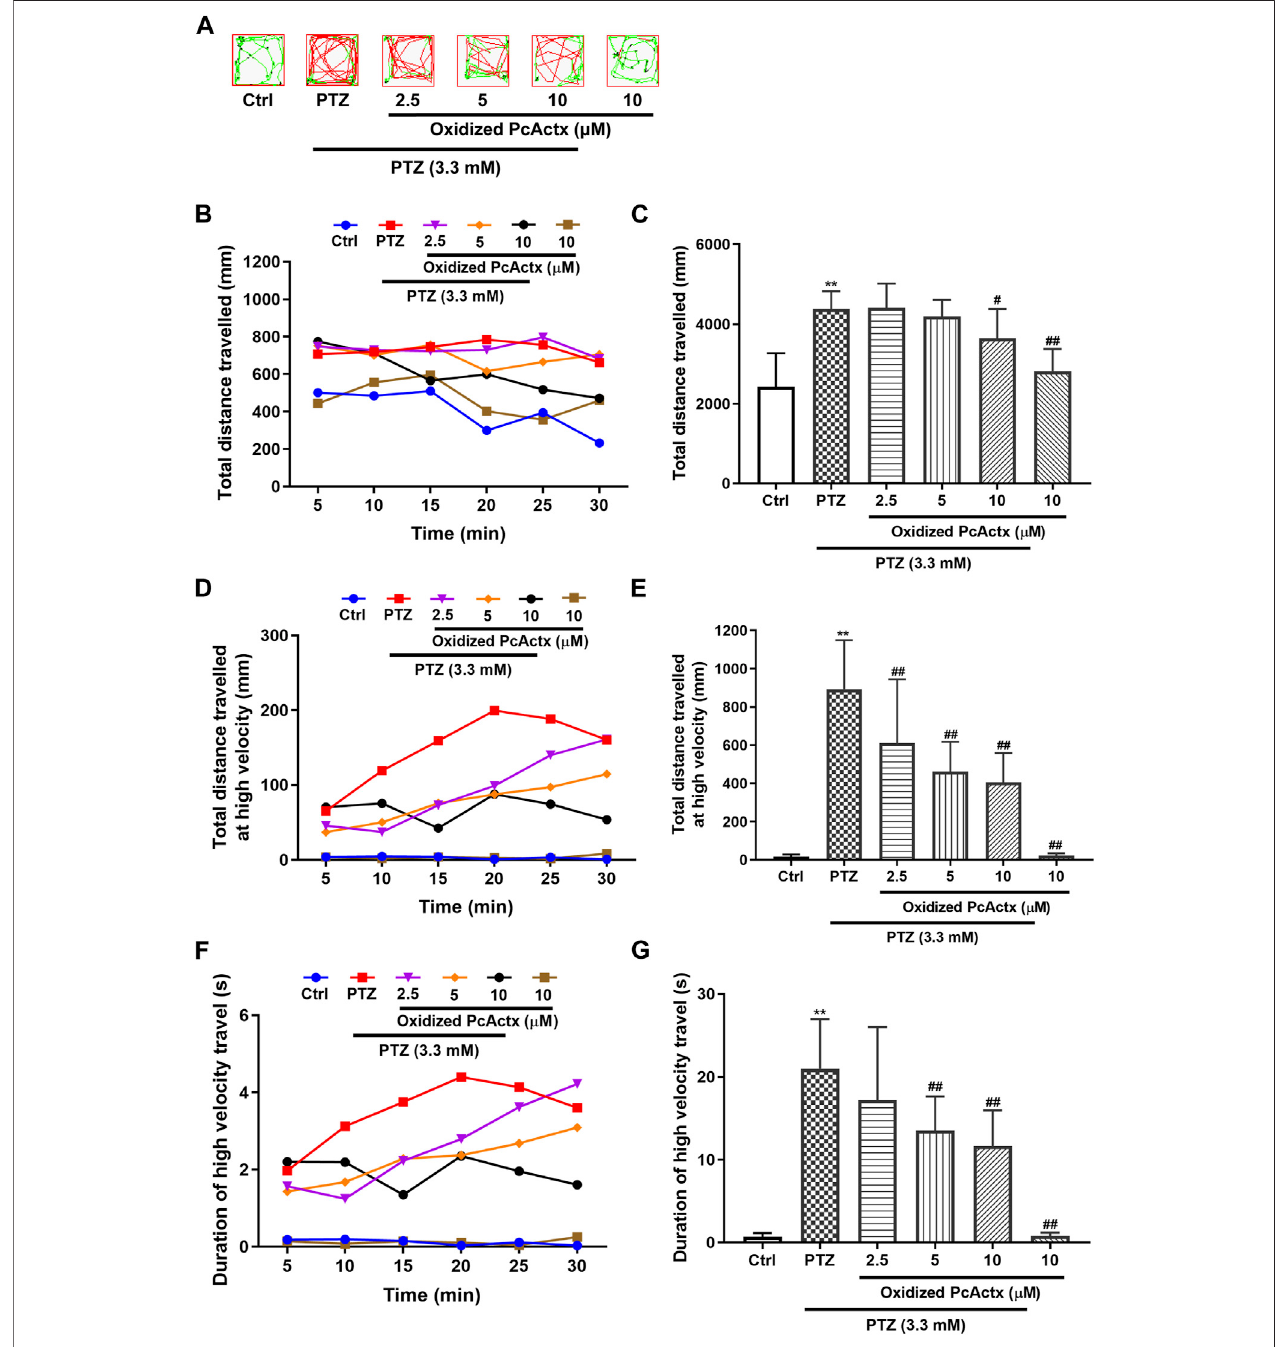
FIGURE7| OxidizedPcActxpeptideinhibitedPTZ-inducedhyperactivityinzebra fi shlarvae. (A) Representativepatternsoflocomotionbehaviorinzebra fi shlarvae. The swimming trajectory was recorded every 5 min and is represented by curves. The instantaneous velocity was detected and displayed in different colors (black, < 2 mm/s; green, 2 – 20 mm/s; red, > 20 mm/s). (B) . Changes in total distance travelled by period. (C) . Statistical analysis of total distance travelled. (D) . Changes in total distancetravelledathighvelocitybyperiod( > 20 cm/s). (E) .Statisticalanalysisoftotaldistancetravelledathighvelocity( > 20 cm/s). (F) .Changesindurationofhigh velocitytravelbyperiod( > 20 cm/s). (G) .Statisticalanalysisofthedurationofhighvelocity travel( > 20 cm/s). Dataareexpressed asmeans ± SD(n (cid:2) 9 – 10).* p < 0.05vs Ctrl group, ** p < 0.01 vs Ctrl group, # p < 0.05 vs PTZ group, ## p < 0.01 vs PTZ group.